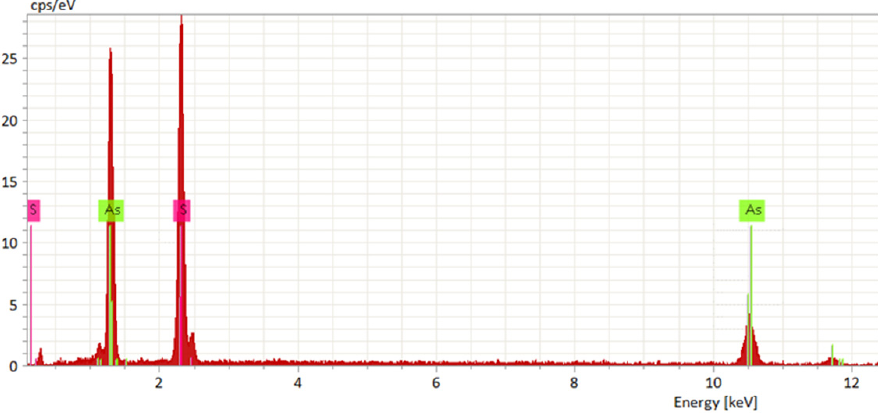
Figure 1. SEM-EDS spectrum for arsenic sulfide (V) from Sigma Aldrich (Merck) [own